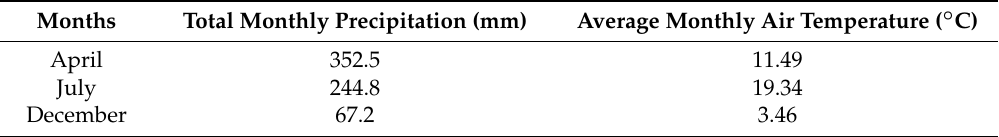
Table 1. Average monthly climatic data of the study site during the experimental periods in